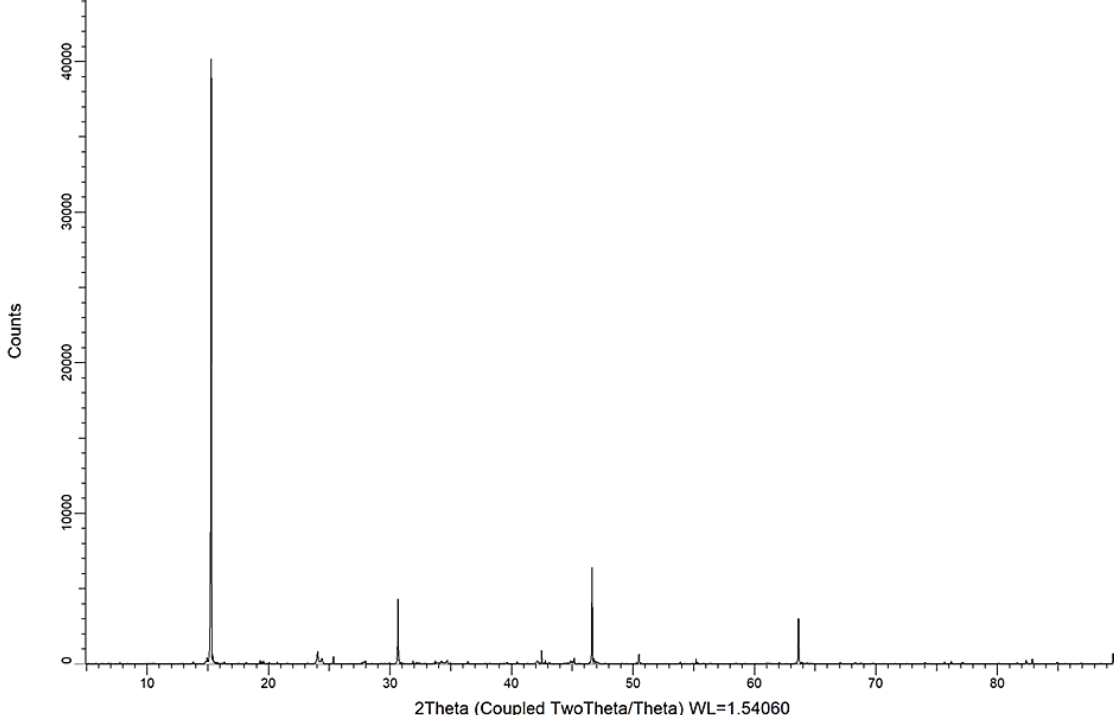
Figure 11. The XRD pattern of Ba(OH) 2 powder.